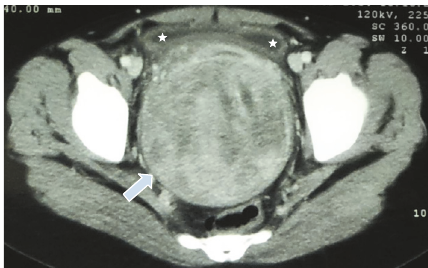
Figure 2: Pelvic CT scan outlining the uterine lesion (white arrow). The compressed bladder lumen is also illustrated (white